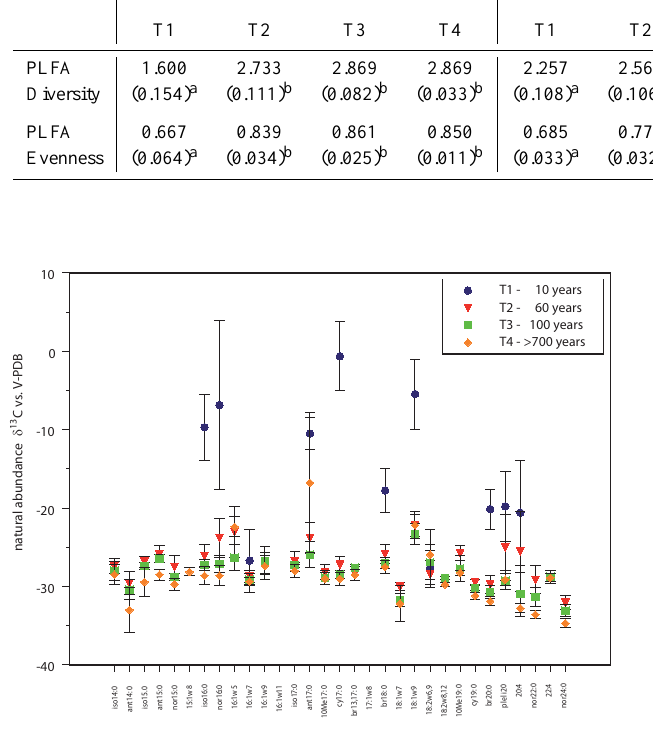
Fig. 3. Natural abundance δ 13 C values [‰ vs V-PDB] of individ- ual PL in control soil without litter application (means ± standard deviation; n = 5) at different locations T1-T4.